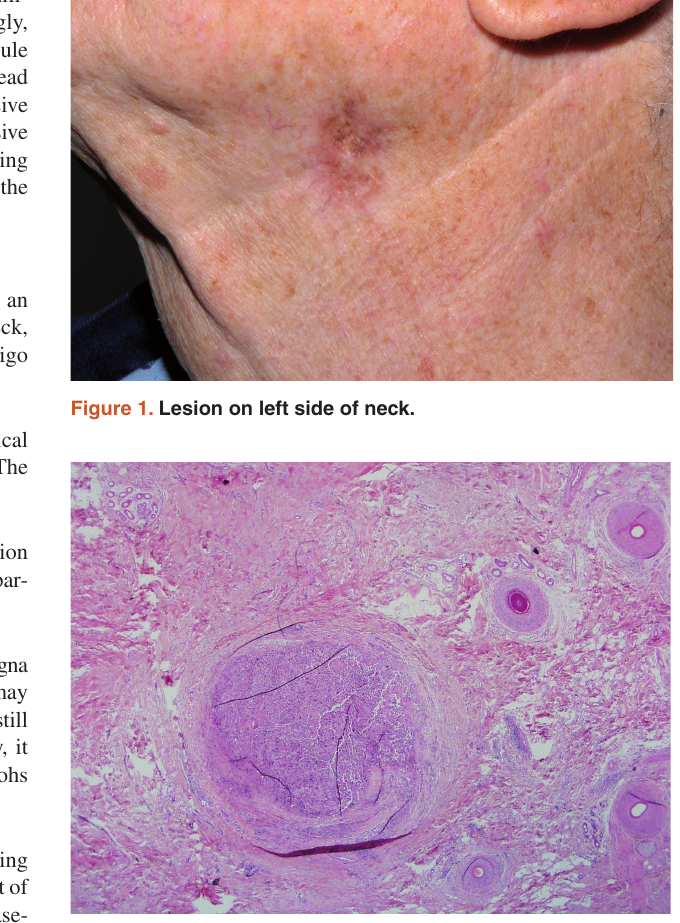
Figure 2. Nodule of atypical melanocytes (H&E ×20).